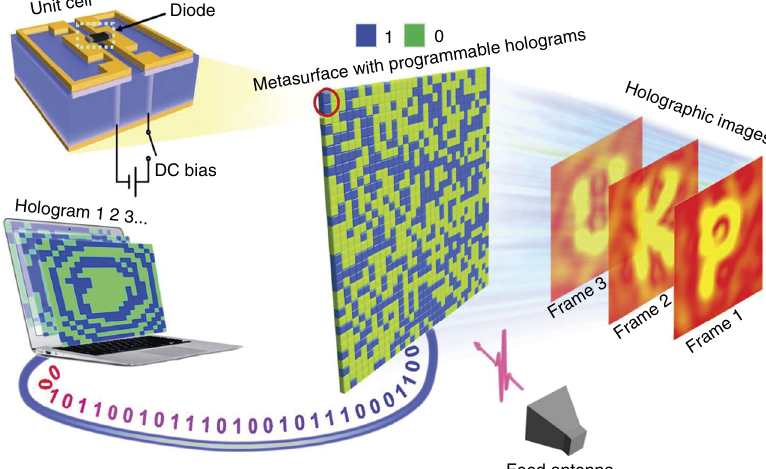
Fig. 1 A sketch of the proposed dynamic holographic imaging. The metasurface in the middle is formed by an array of meta-atoms, with each having a pin diode welded between the two metallic loops and independently controlled by a DC voltage through a via (see the unit cell in the upper left corner ). A computer digitally controls the metasurface by dynamically changing the phase distribution (Hologram 1, 2, 3, … ) computed from the modi fi ed GS algorithm. Under the illumination of a feeding antenna (on the bottom right side ), the metasurface hologram can successively project the holographic images (Frame 1, 2, 3 … ) at the imaging plane ( Z r ), showing the letters ‘ P ’ , ‘ K ’ , ‘ U